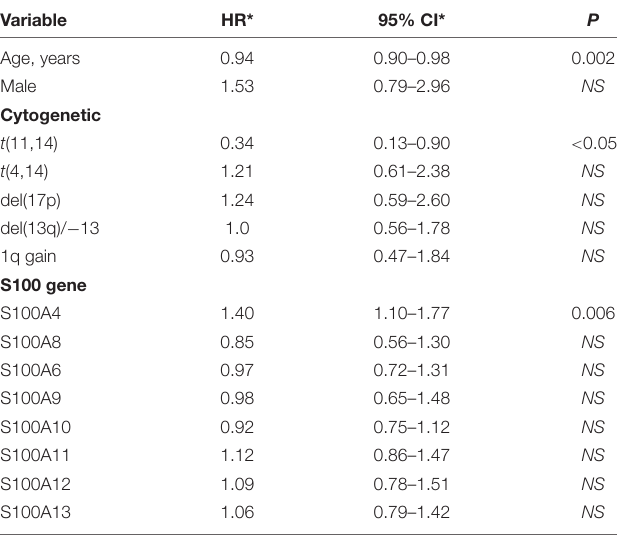
TABLE 2 | Multivariate analysis of overall survival in the FIMM dataset ( n =